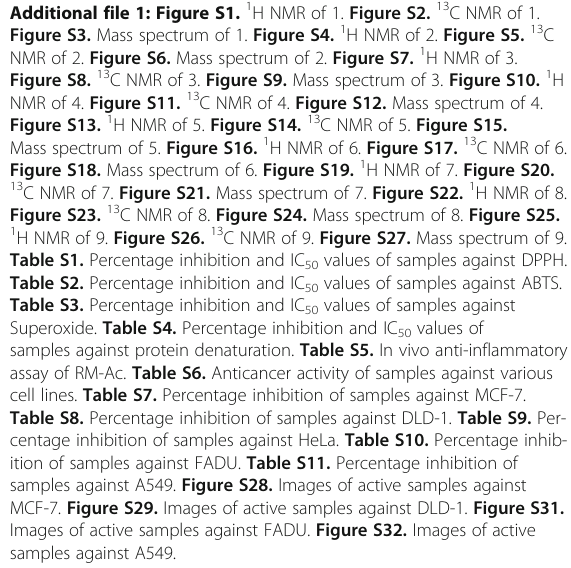
MCF-7. Figure S29. Images of active samples against DLD-1. Figure S31. Images of active samples against FADU. Figure S32. Images of active samples against